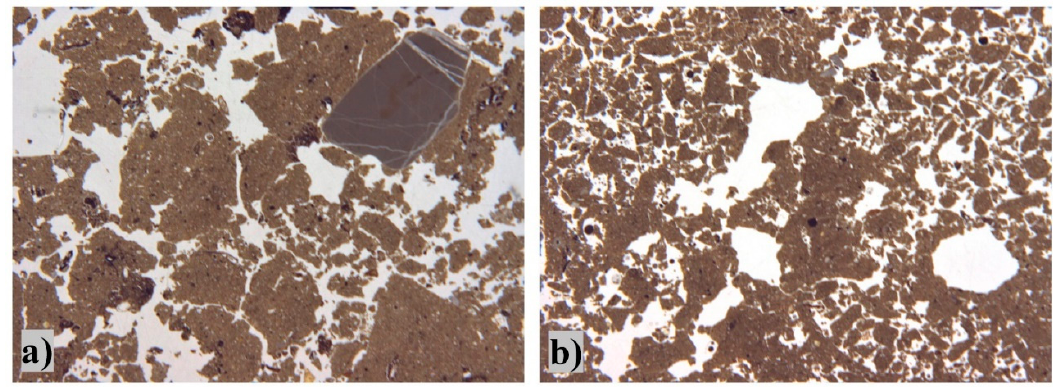
Figure 4. Macrophotographs of soil thin sections of two soils with the same bulk density, but quite different structure and pore distribution. ( a ) subangular blocky structure, ( b ) granular structure. The horizontal length of a section is 32 mm.